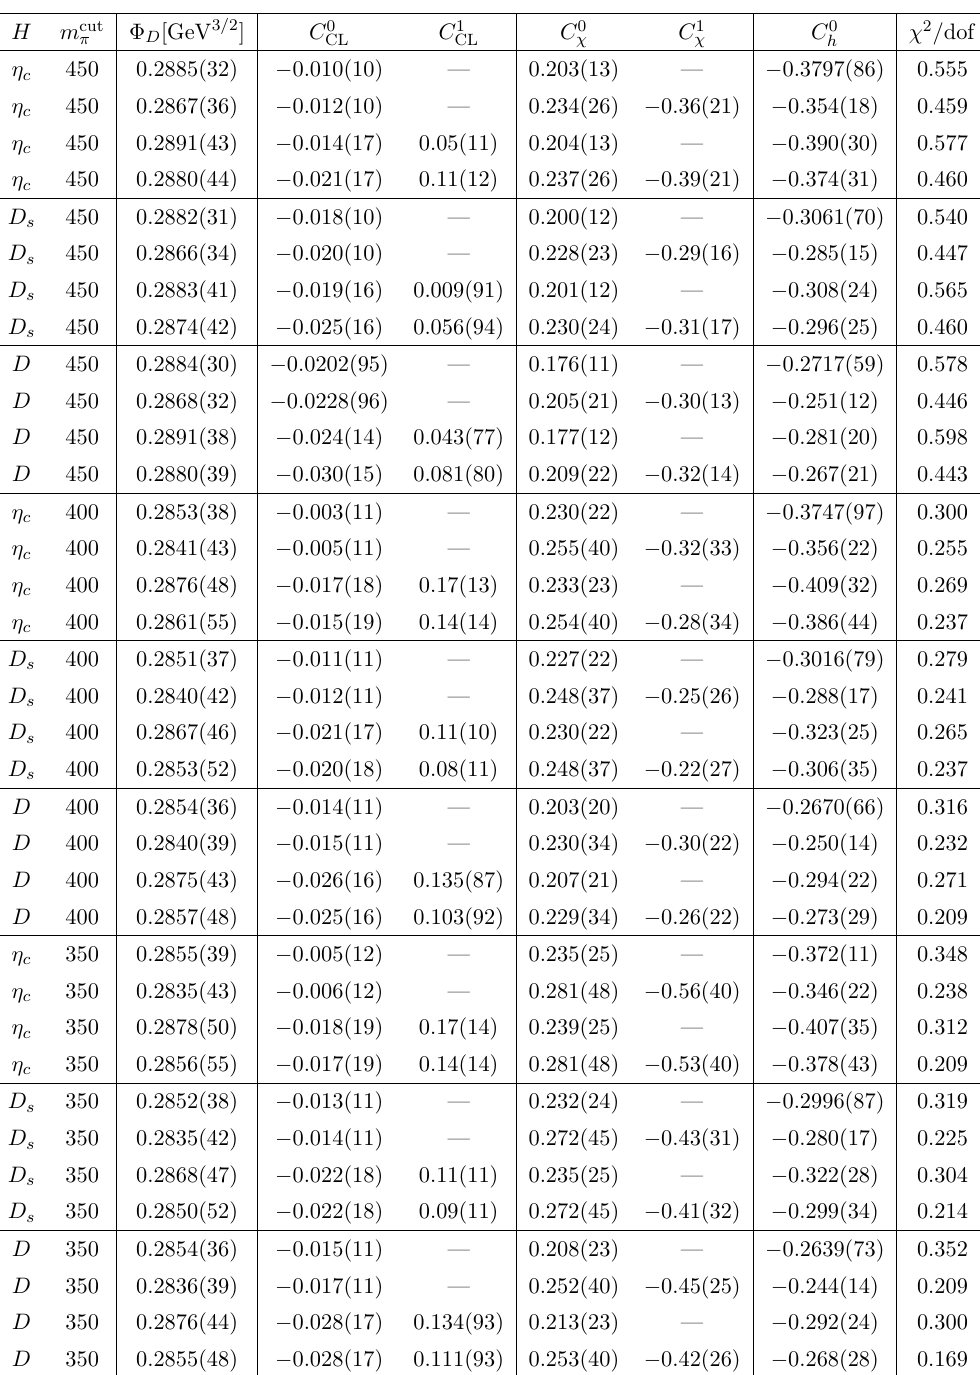
Table 15 . Fit results of the di(cid:11)erent versions of the global (cid:12)t ansatz (3.6) for the observable (cid:8) D